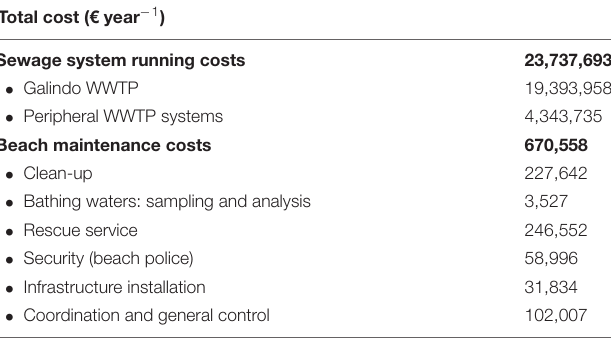
TABLE 1 | Annual costs (excluding VAT) of the sewage system [Wastewater Treatment Plant (WWTP) of Galindo and peripheral systems] and maintenance of beaches.